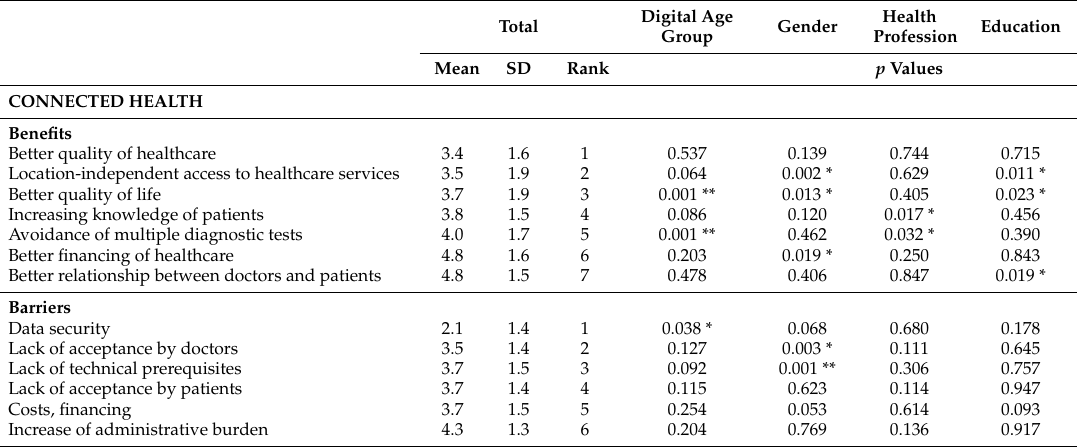
Table 3. Ranking of connected health-related benefits and barriers, ordered by total rank. Total Digital Age Group